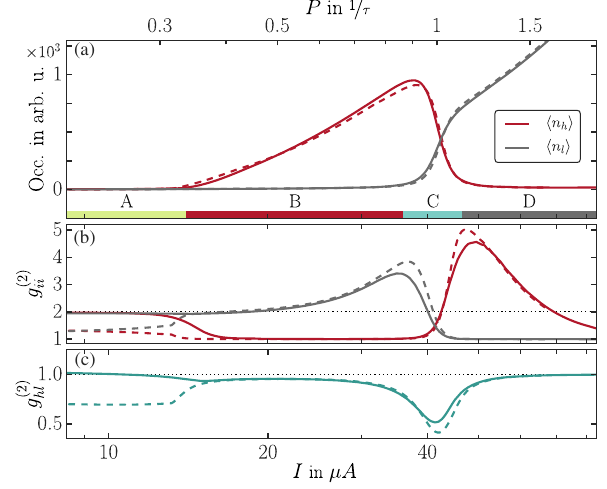
2 Þ FIG. 7. Comparison of h n and g ð obtained from the i i ij numerical, exact Monte Carlo simulation of Eq. (2) (solid lines) with the ones obtained from the direct solution of the reduced density matrix Eq. (B1) (dashed lines). Note that the pump in the reduced density matrix is scaled to compensate for β ≠ 1